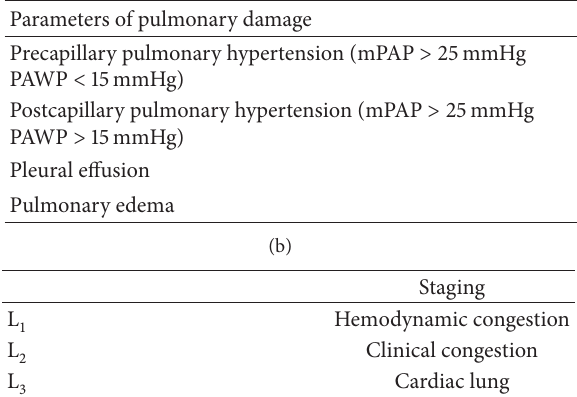
are the Cockroft-Gault and MDRD (Modification of Diet in Renal Disease), although currently the most widely used is a modification of the simplified MDRD formula (sMDRD or simplified